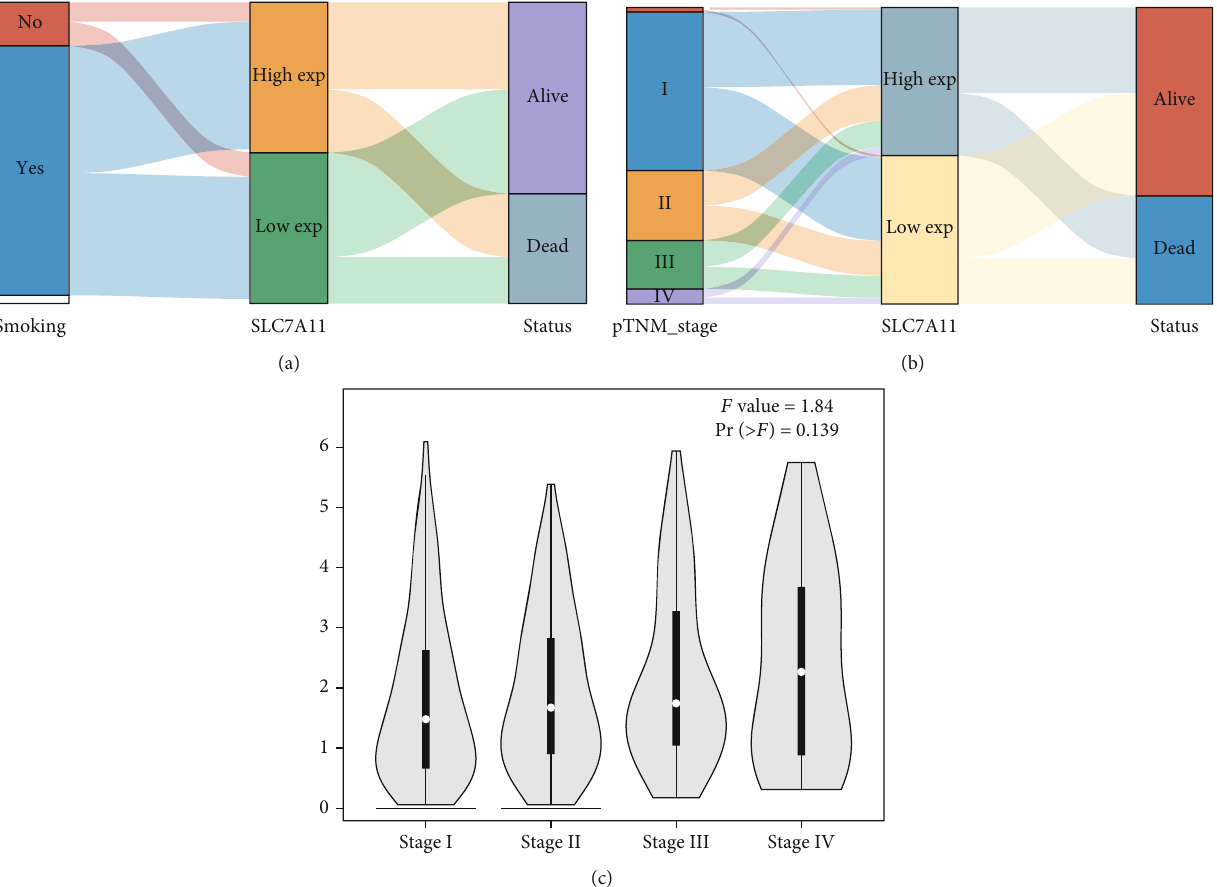
Figure 5: The correlation between SLC7A11 and clinicopathological parameters in LUAD. Sankey diagrams between SLC7A11 and (a) Smoking and (b) pTNM_stage. (c) High expression of SCL7A11 was identi fi ed in LUAD samples with phases III-IV in contrast to phases